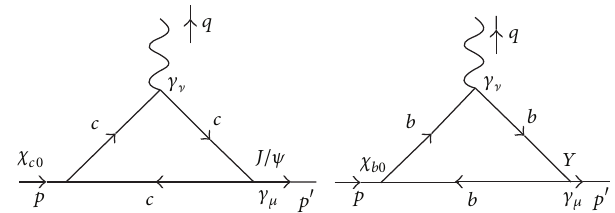
Figure 1: The bare loop diagram for the 𝜒 𝑐0 → 𝐽/𝜓𝛾 and 𝜒 𝑏0 → Υ𝛾